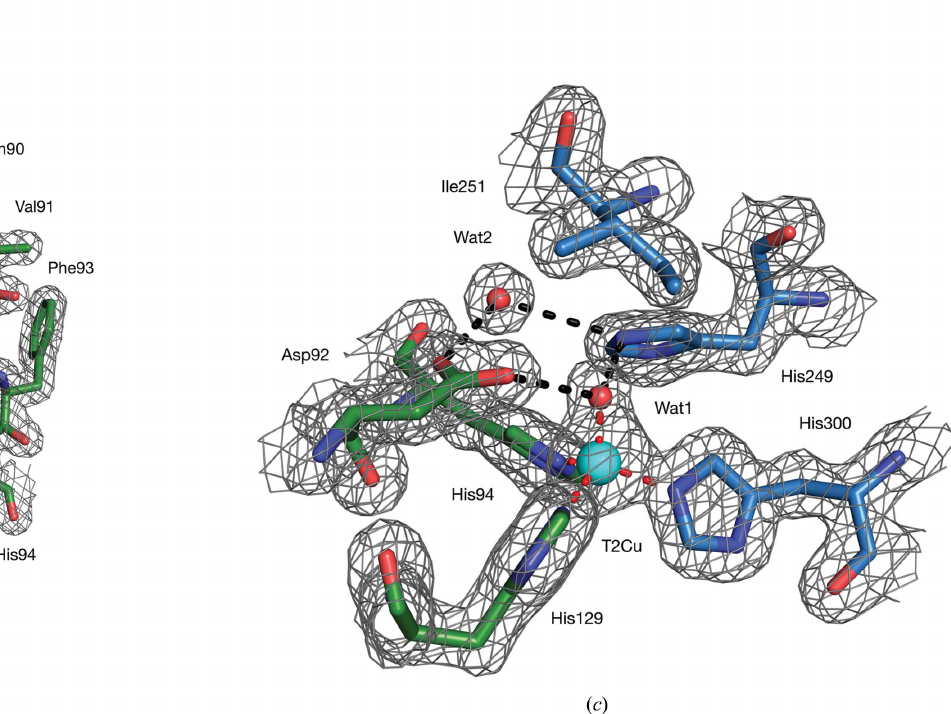
Figure 2 Structural organization of Ax NiR. ( a ) The Ax NiR trimer is viewed from the top down. The T1Cu is shown on the surface of the molecule, where it accepts electrons from carrier proteins. The T2Cu ion can be seen at the monomer–monomer interface. ( b ) Details of the SRX T1Cu and T2Cu sites. Electrons donated to the T1Cu are transferred along a Cys130–His129 bridge to the T2Cu. The catalytic Asp92 and His249 residues are positioned next to the substrate as the proton supply. ( c ) Resting state of the Ax NiRT2Cu site (SRX). The T2Cu is ligated by three histidine residues and a water ligand Wat1, which is hydrogen-bonded to two catalytic resides Asp92 CAT and His249 CAT , which in turn are linked to water Wat2. Wat1 is always observed in all resting-state CuNiR structures obtained at synchrotron facilities. 2 F o (cid:3) F c electron density is contoured at the 2 (cid:5) level and shown as a grey mesh. Atoms are coloured by element, with a different colour scheme used for the different chains. T1Cu is shown as a dark blue sphere, T2Cu as a cyan sphere and water molecules as small red spheres. Metal-coordinating bonds are shown as red dotted lines. Selected hydrogen bonds are shown as black dotted